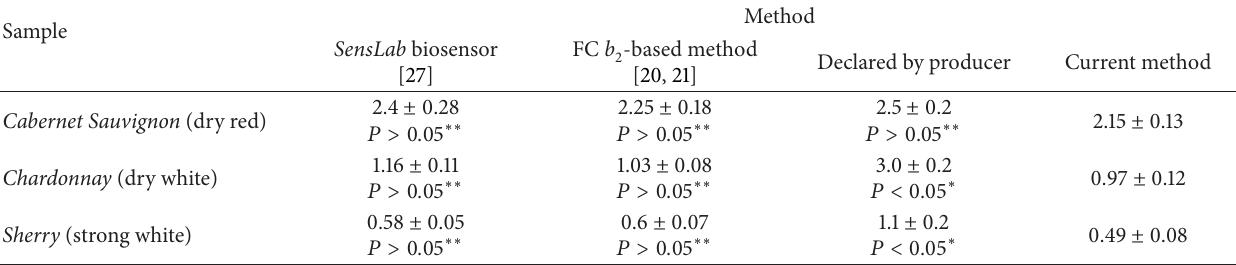
Table 3: Comparison of the results of L-lactate assay (in g ⋅ L − 1 ) in wine samples.